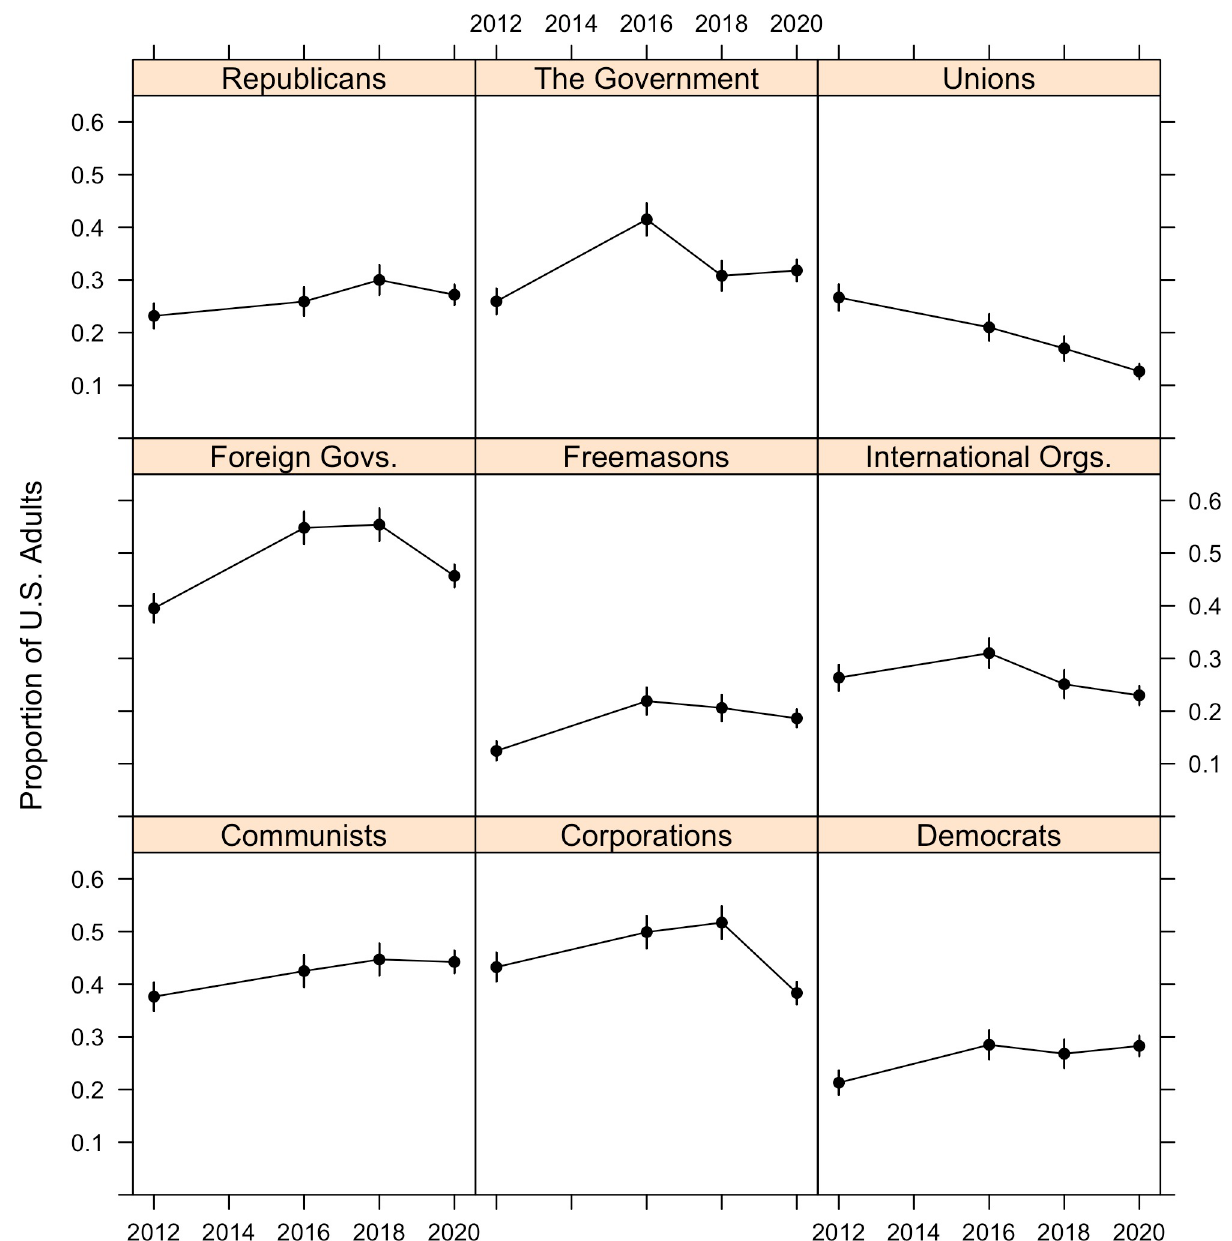
Fig 3. Proportion of U.S. adults who beliefs that each group is “likely to work in secret against the rest of us” over time. average change in proportion across all nine groups of conspirators is –0.13. This is further reflected in an examination of the average count of conspirators that respondents selected: in 2012 respondents selected 2.56 groups, on average, and 2.70 groups in 2020. This difference is not statistically significant at conventional levels ( p = 0.09). In sum, while fears about particular conspirators ebb and flow over time, we do not observe an average increase in the number of conspirators that people are worried about. Moreover, decreases in the proportion of individu- als expressing worry about various conspirators outweigh the observed increases.